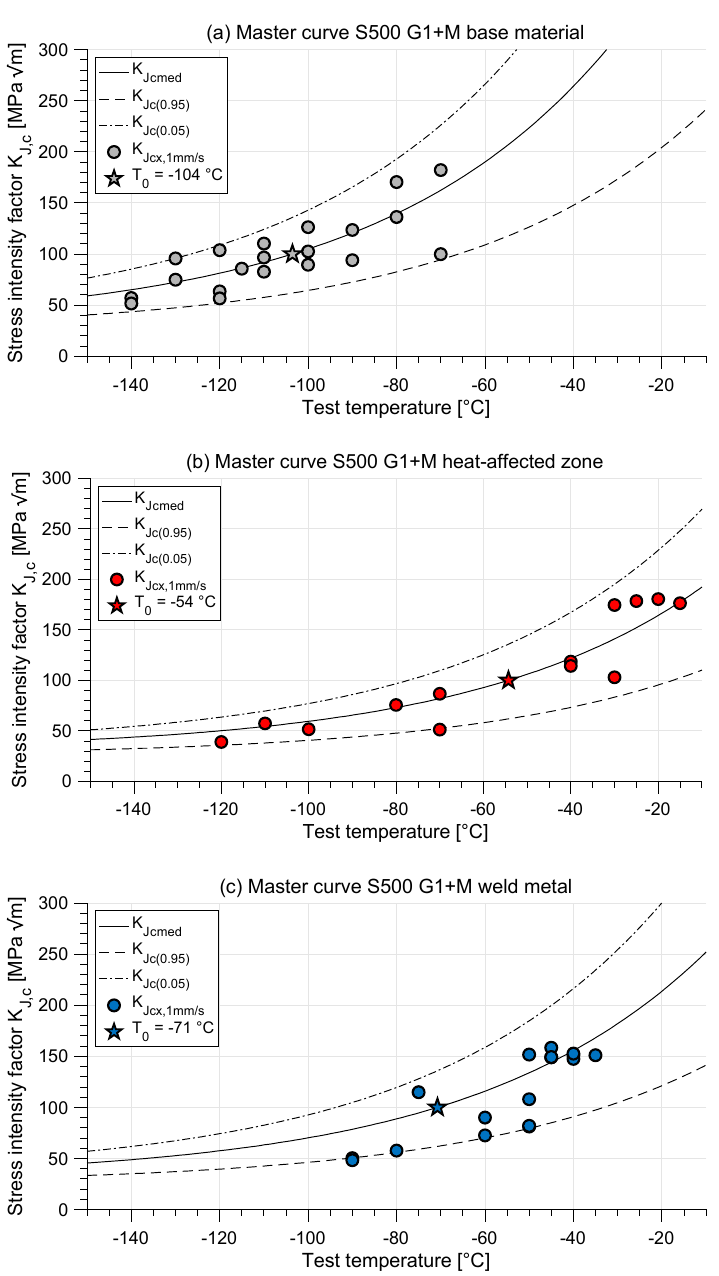
Figure 11. Fracture toughness master curve results for ( a ) base material, ( b ) heat-affected zone, and ( c ) weld metal of S500G1+M steel; with T 0 temperature marked by a star.